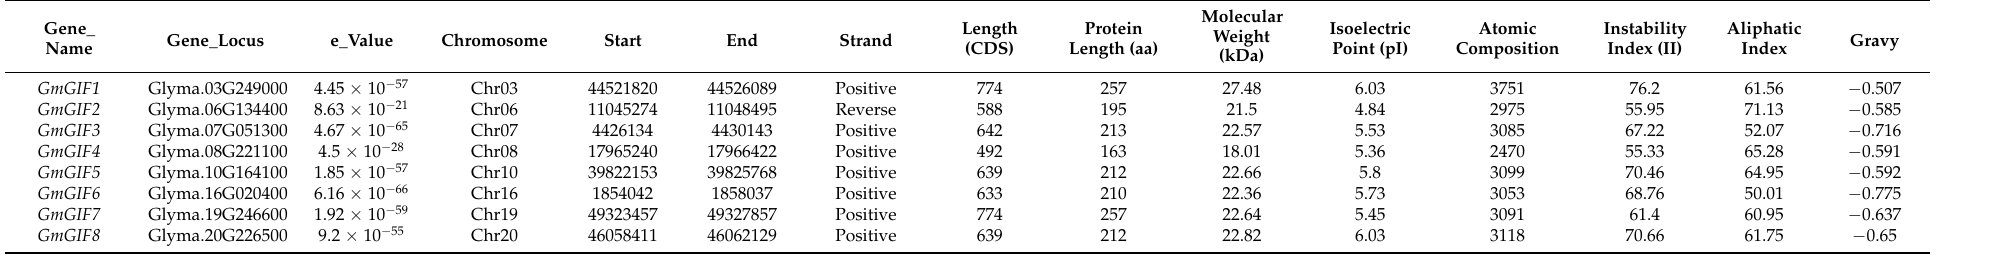
Table 1. Gene list and physicochemical and biochemical characteristics of GIF genes in